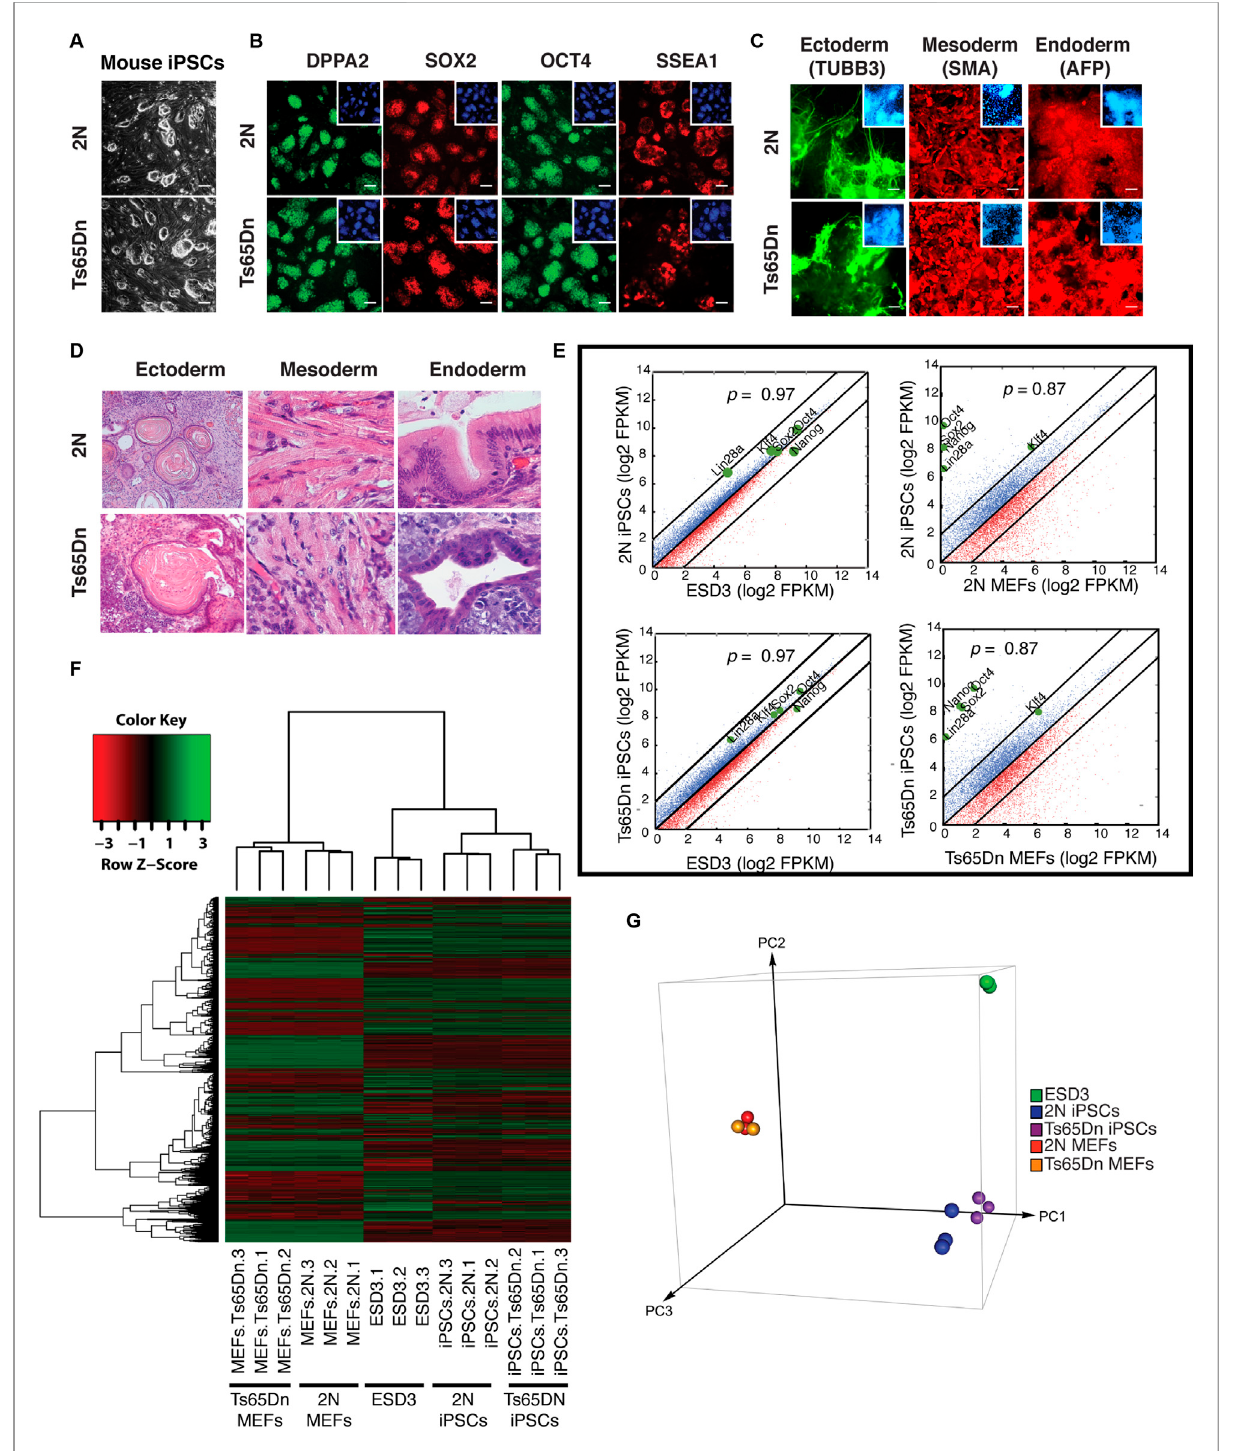
FIGURE 1 Mouse iPSCs generation and characterization. (A) Representative images of 2N and Ts65Dn mouse iPSCs (miPSCs) clones on the feeder layer. (B) Pluripotency characterization of miPSCs using ICC for pluripotency-associated markers DPPA2 (green), SOX2 (red), OCT4 (green), and SSEA1 (red).InsertsshowcorrespondingDAPI(blue)stainingforeachimage. (C) Invitro developmentalpotentialof2NandTs65DnmiPSCsischaracterized by the expression of markers of three germ layers. ICC was done for Tubulin beta 3 (TUBB3) (green) for ectoderm, Smooth muscle actin (SMA) (red) for mesoderm, and Alpha fetal protein (AFP) (red) for endoderm. Inserts show corresponding DAPI (blue) staining for each image. (D) Representative images of ectodermal (skin epithelium), mesodermal (muscle), and endodermal (cuboidal epithelium) lineage tissues in teratomas